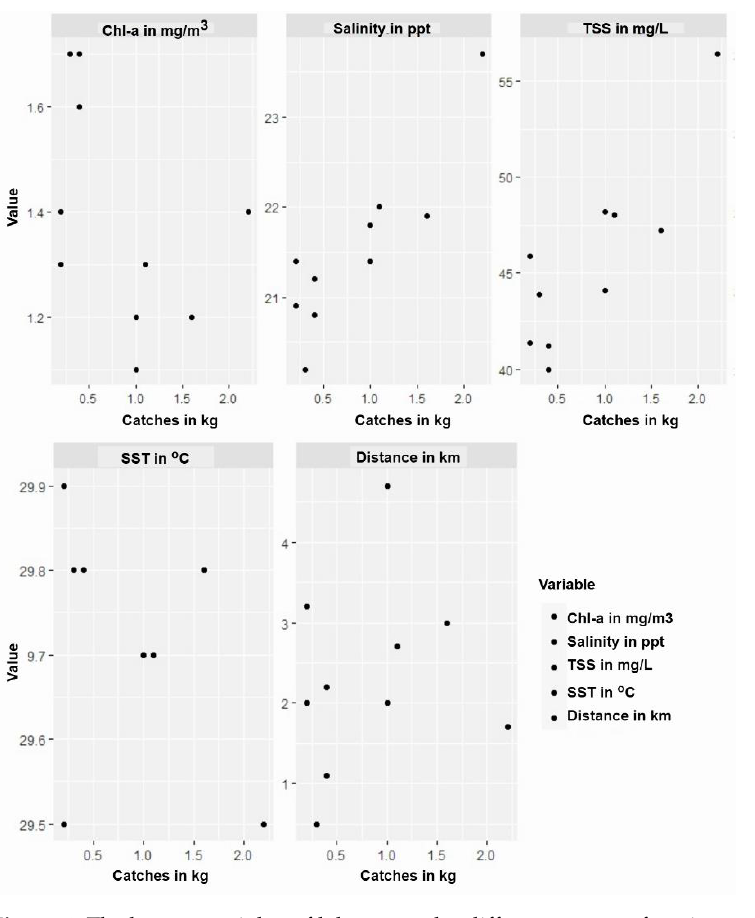
Figure 4. The harvest weights of lobsters under different ranges of environmental conditions.